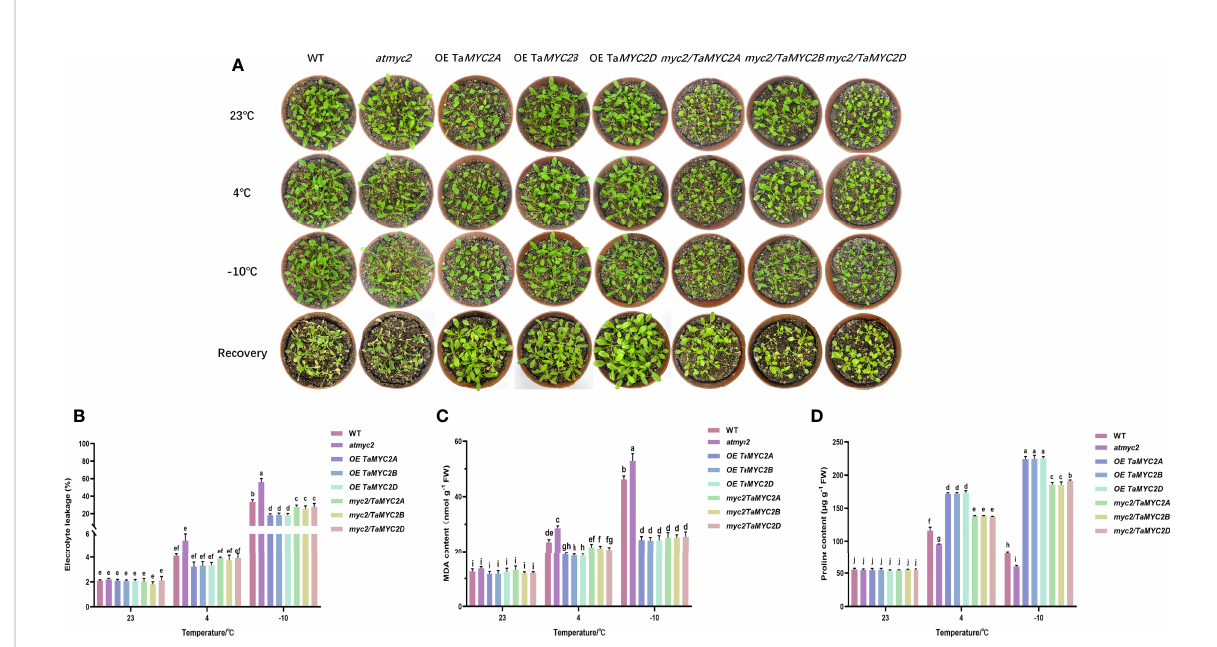
FIGURE 3 Phenotype investigation and physiological index measurement of WT, atmyc2 mutants and transgenic plants under cold stress. (A) Cold resistance phenotypes of WT, atmyc2 mutants and transgenic plants. (B) Electrolyte leakage, (C) MDA content, and (D) proline content of the WT, atmyc2 , and transgenic plants. The top to bottom on the right side of each bar chart corresponds to the left to right of the same temperature. The error lines were obtained from three biological replicates. The mean values of the experimental data were analyzed by one- way ANOVA analysis. The comparison method was the least signi fi cant difference (LSD), and the bar graphs with different letters indicated signi fi cant differences ( p <